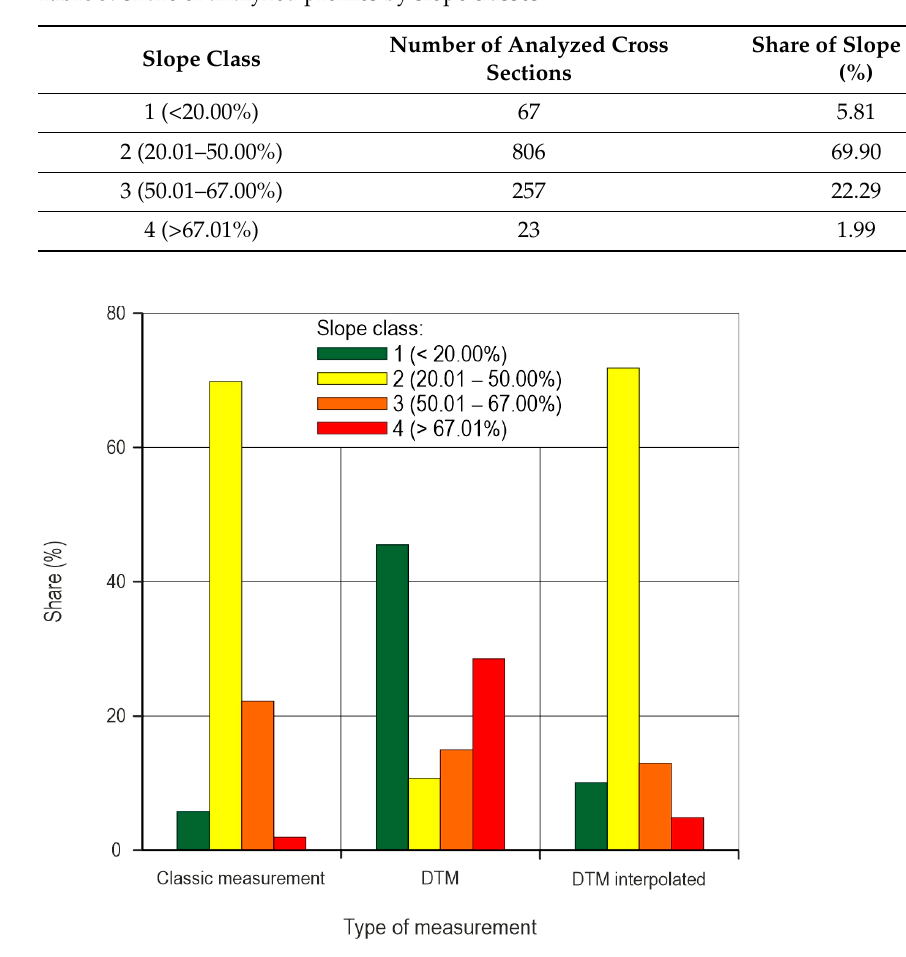
“trim”and “extend”, profile line ends could be brought into the exact position of contact